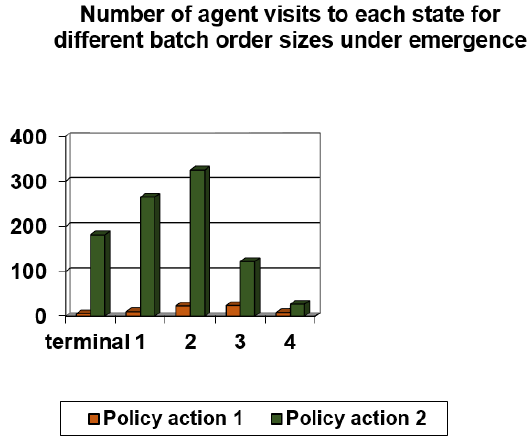
Figure 10. The number of agent visits to each state for the scheduling of one batch of 28 orders and four emergency orders, with mean order size three line items per order. The agent followed a non-ε-greedy policy with ε = 0.